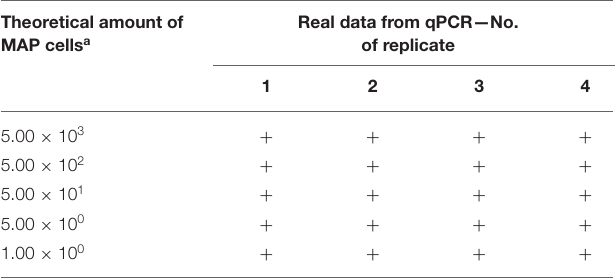
TABLE 1 | Determining the limit of detection of the Actiphage assay in milk. Theoretical amount of MAP cells